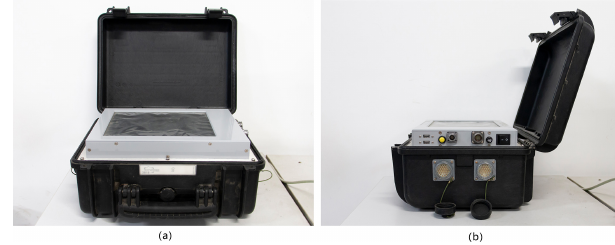
Figure 1. Photograph of realized CUGB-CS48DAS.